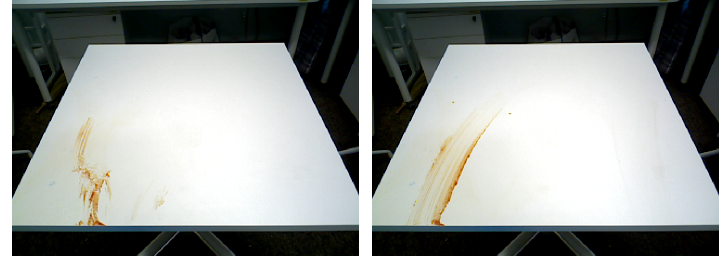
Figure 10. Outcome of cleaning task for stains and spillages.